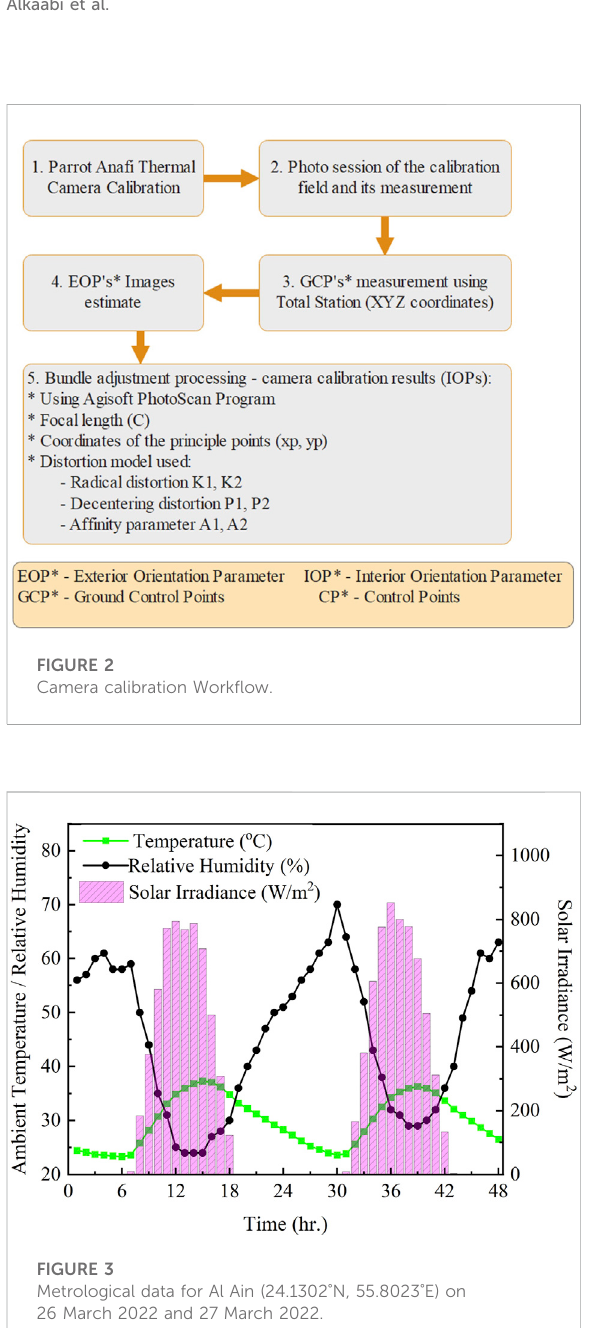
FIGURE 3 Metrological data for Al Ain (24.1302 ° N, 55.8023 ° E)